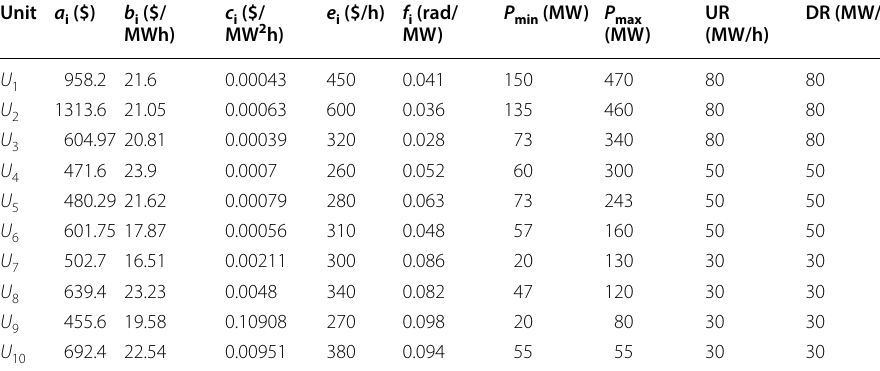
Table 7 Characteristic input data of the 10-unit system